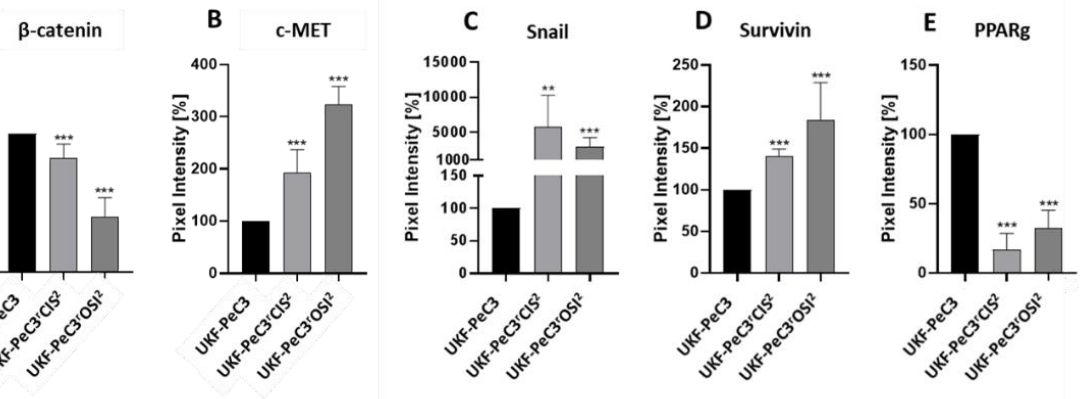
Figure 4. Western blot analysis: Pixel density analysis of the protein expression of β -catenin ( A ), c-Met ( B ), snail ( C ), survivin ( D ), and PPARg ( E ) in UKF-PeC3 r CIS 2 and PeC3 r OSI 2 cells, compared to UKF-PeC3 cells (set to 100%). Analysis of pixel density was normalized by a total protein staining. Error bars indicate the standard deviation (SD). Significant difference from UKF-PeC3: ** = p ≤ 0.01, *** = p ≤ 0.001.